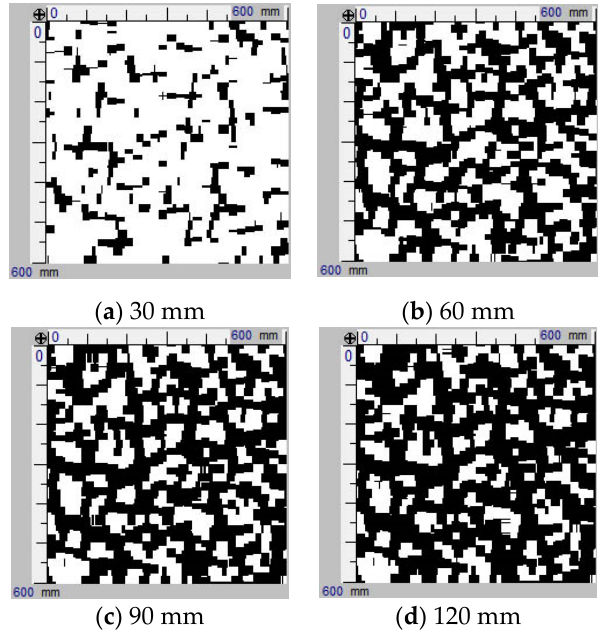
Figure 2. Exemplary images of a scanned area (600 mm · 600 mm) at various depths using the electromagnetic induction technique.